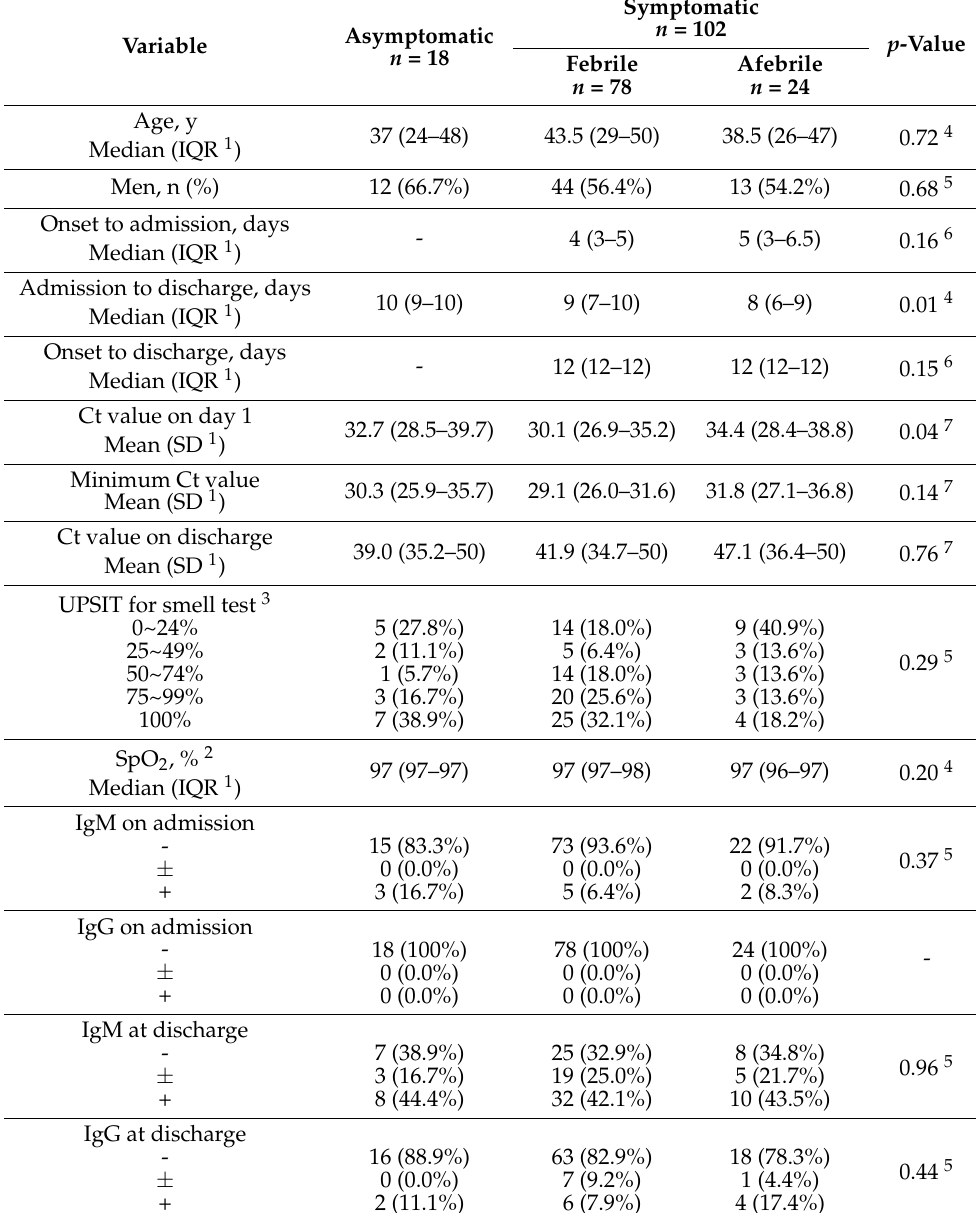
Table 1. Patients’ characteristics stratified by three groups: asymptomatic, dysosmia/dysgeusia, and